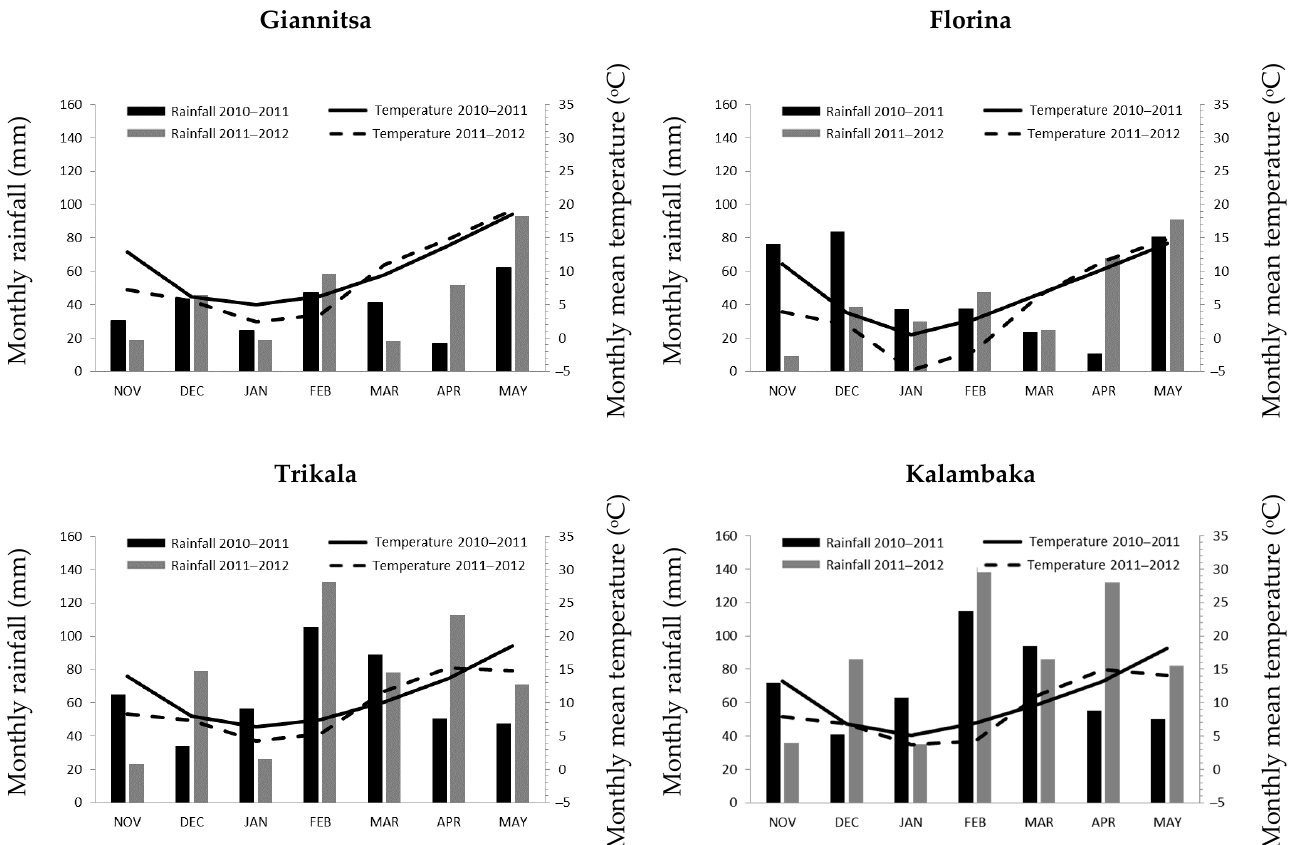
Figure 1. Basic weather data (mean monthly temperature in °C and rainfall in mm) based on daily records, through two growing seasons.